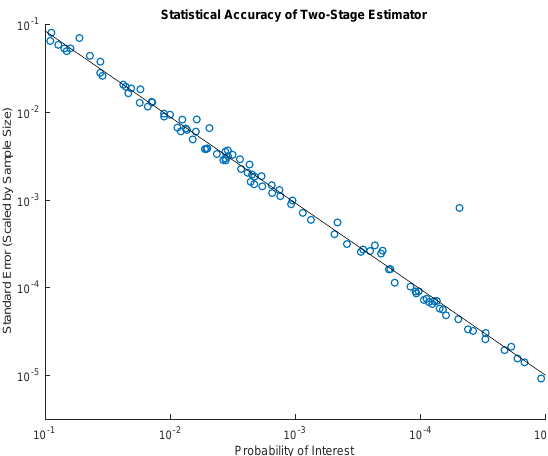
Figure 6. This figure illustrates the relationship between ν x and p x , where ν x is the standard deviation